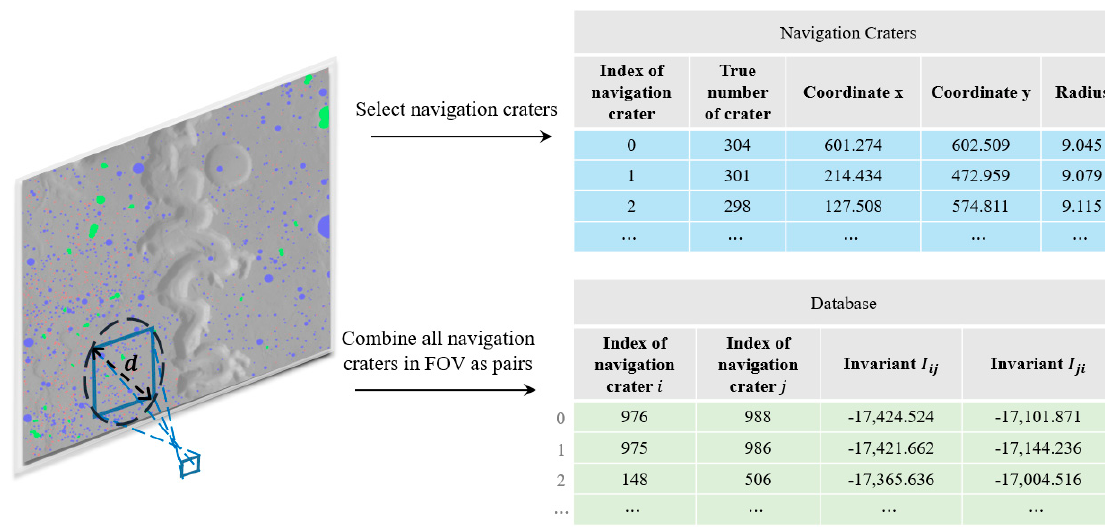
Figure 2. Navigation craters are selected, and all navigation craters in the field of view (FOV) are combined as pairs. The figure shows navigation craters and the database of crater pairs. The record in ”Navigation Craters” includes the index of the navigation crater, the true serial number of the crater, coordinate x , coordinate y , and the radius. The record in “Database” includes the index of navigation crater i , index of navigation crater j , and invariants I ij and I ji .